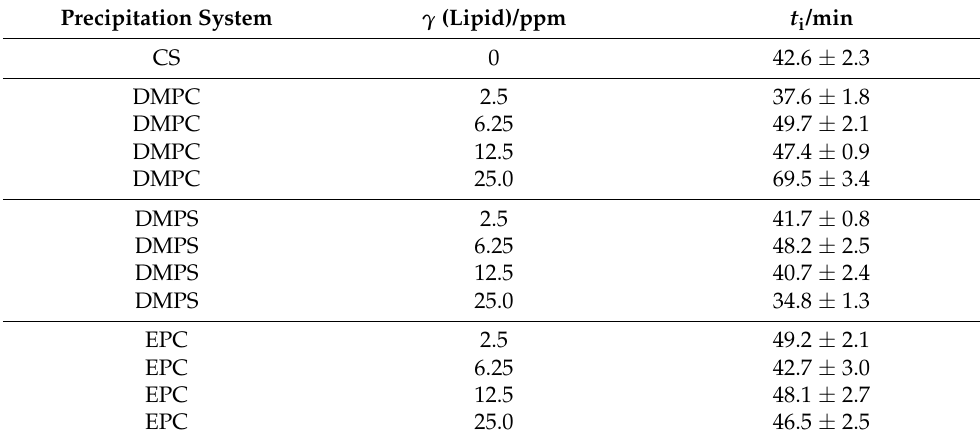
Figure 1. ( a ) Representative pH vs. time progress curve of formation and transformation of calcium phosphate solid phases in the absence (CS) and presence of 12.5 ppm (spheres) and 25.0 ppm (triangles) lipids. ( b ) The dependence of average induction time ( t i, calculated from pH vs. time curves) on lipid concentration is given. c i (Ca) = c i (PO 4 ) = 3.5 mmol dm −3 ; pH i = 7.4; ϑ /°C = 25 ± 0.1. Table 1. Average induction times ( t i ) obtained from pH vs. time ( t ) curves from 3 measurements with standard deviations (SDs). c i (Ca) = c i (PO 4 ) = 3.5 mmol dm − 3 ; pH i = 7.4; ϑ / ◦ C = 25 ± 0.1. Liposome concentrations are expressed as lipid